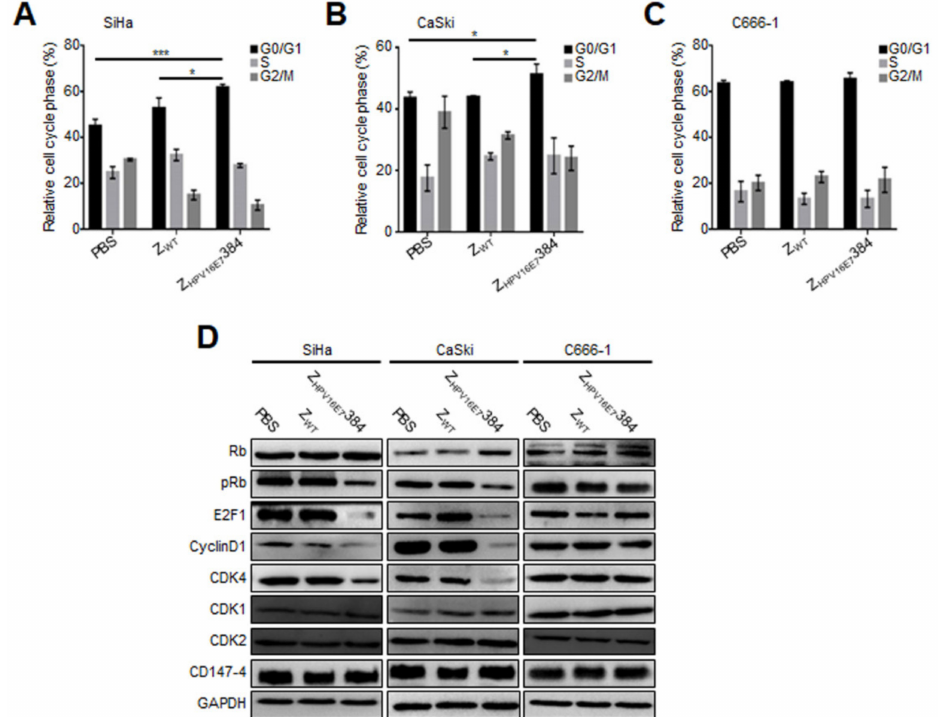
Figure 3. Z HPV16E7 384 induced G1/S cell cycle arrest by interfering with the E7/Rb/E2F1/cyclin D1/CDK4 pathway. ( A – C ) A cell cycle analysis was performed to evaluate the effect of Z HPV16E7 384 on the cell cycle. Cells treated with Z WT or PBS were used as the negative controls. ( D ) Cell cycle related proteins in cells with the same treatment as in ( A – C ) were analyzed by Western blot. The data shown are representative of three independent experiments. All experiments were performed in triplicate and data are expressed as the means ± SD ( n = 3). * p < 0.05, *** p < 0.001. Western blot was then performed to determine the expression of the cellular proteins that were involved in Z HPV16E7 384-induced G1/S cell cycle arrest. As shown in Figure 3D, compared with the control cells, the cell cycle related proteins including phosphorylated retinoblastoma protein (pRb), E2F1, cyclin D1, and CDK4 in the Z HPV16E7 384-treated SiHa and CaSki cells were significantly downregulated whereas Rb was upregulated. However, other cell cycle related proteins including CDK1, CDK2, and CD147-4 were not affected by Z HPV16E7 384 treatment. Taken together, these results indicate that Z HPV16E7 384 was internalized specifically into the target cells, leading to G1/S cell cycle